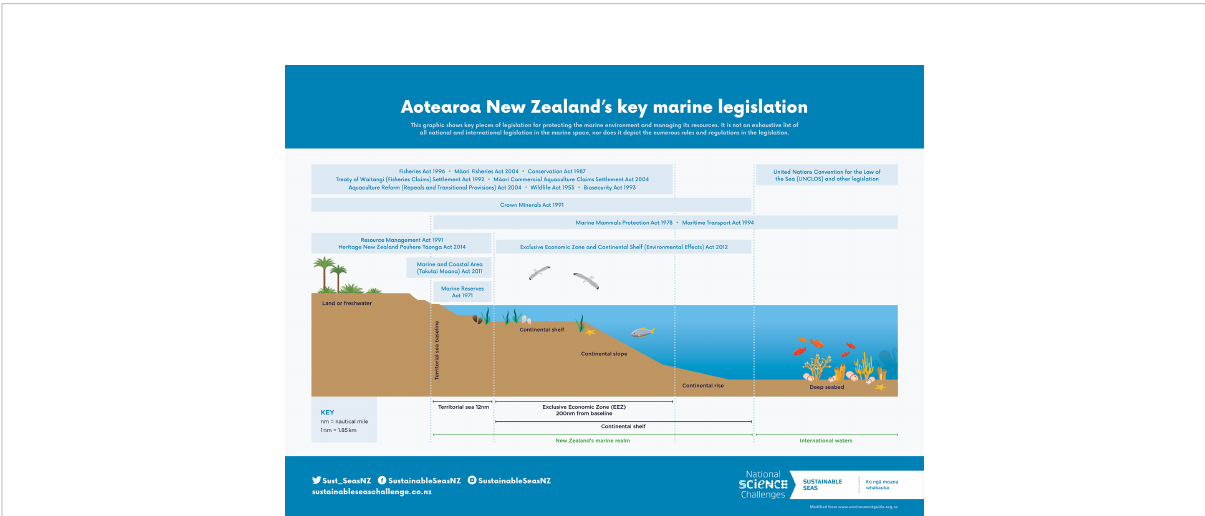
FIGURE 1 Summary of Aotearoa-New Zealand major legislation related to the marine area (from 19679-Sustainable-Seas-Marine-Legislation-Graphic- Nov20-FINAL.PNG (1920×1358) (sustainableseaschallenge.co.nz)). Grey shaded horizontal bars show the areas (terrestrial, coastal, territorial sea, exclusive economic zone and international waters) that the pieces of legislation refer to. Horizontal lines at the bottom de fi ne the national and international